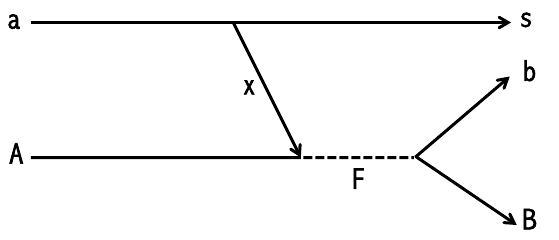
Figure 1. Scheme of a quasi-free Trojan Horse reaction A(a,bB)s. The upper vertex shows the a → x + s breakup. The lower vertex shows the reaction of astrophysical interest, which proceeds through the formation of intermediate system F. If the process is QF, the nucleus s will act as a spectator. If the bombarding energy E A is chosen high enough to overcome the Coulomb barrier in the entrance channel of the three-body reaction, both the Coulomb barrier and electron screening effects are